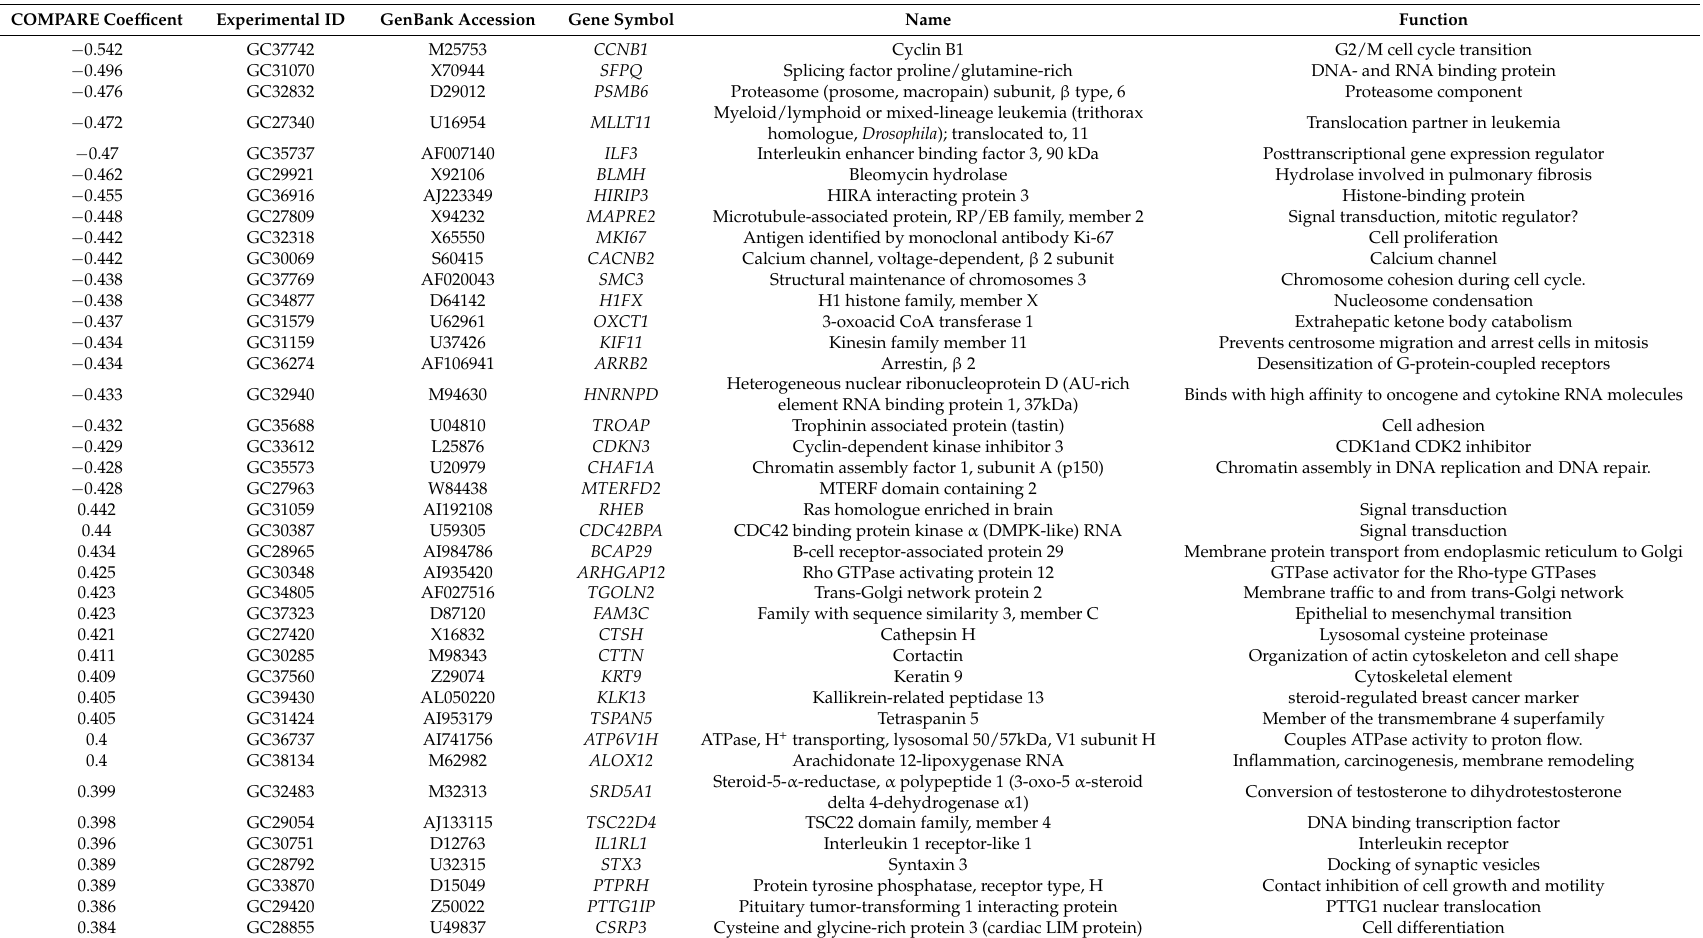
Table 2. Correlation of constitutive mRNA expression of genes identified by COMPARE analyses with log 10 IC 50 values of scopoletin for the NCI tumor cell